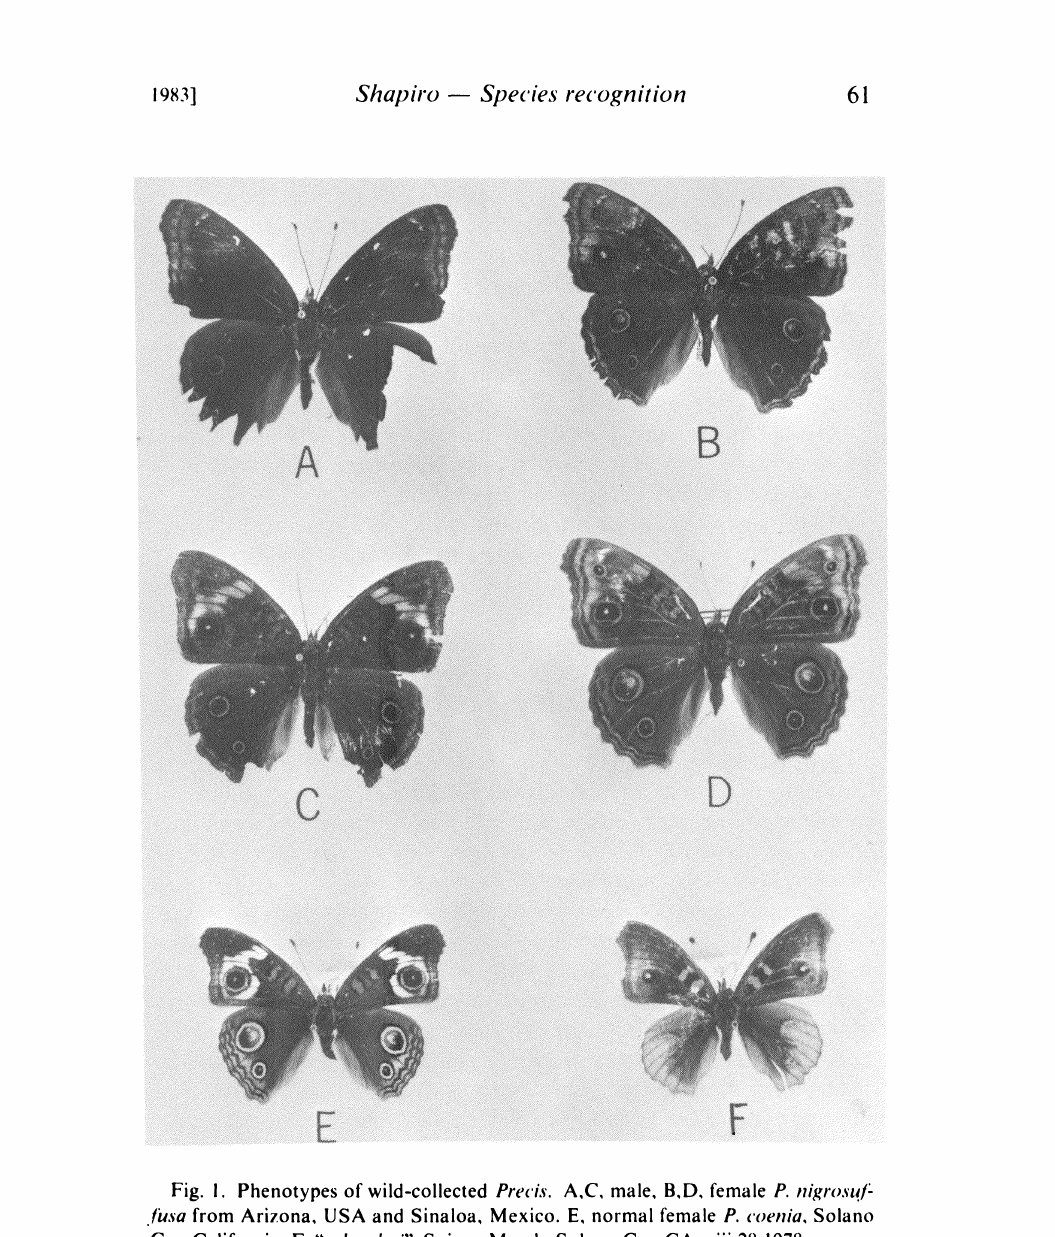
Fig. I. Phenotypes of wild-collected Precis. A,C, male, B,D, female P. nigrosu.f- .l’usa from Arizona, USA and Sinaloa, Mexico. E, normal female P. coenia, Solano Co., California. F. "schraderi", Suisun Marsh, Solano Co., CA,